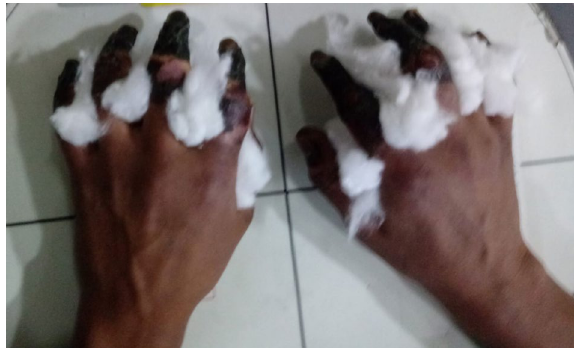
Fig. 1 Physical examination demonstrated gangrene involving all digits of both hands, concluding a